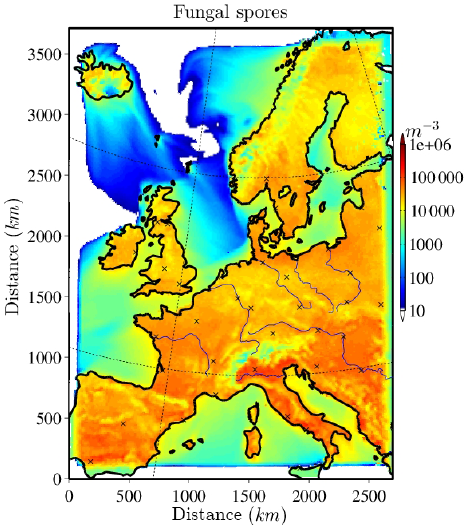
Figure 3. Fungal spore concentration at surface